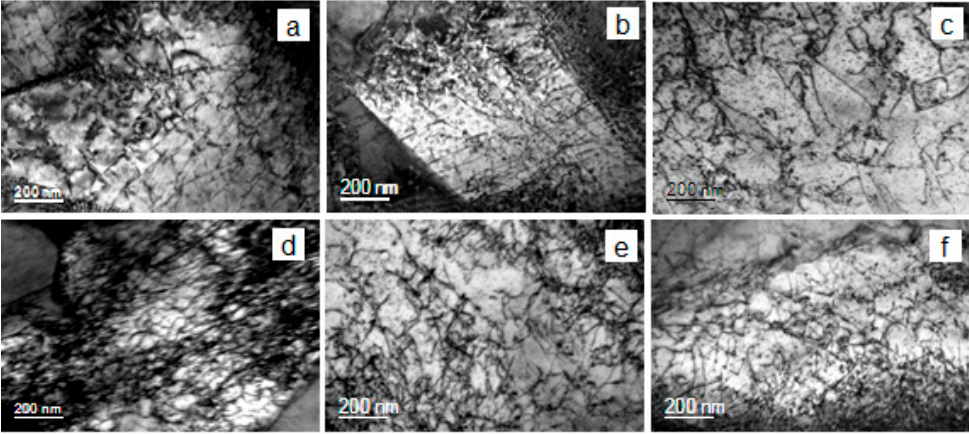
Figure 10. TEM images of typical dislocation structure in ( a – c ) Ti ‐ steel and ( d – f ) MoNbTi ‐ steel, after processing according to schedule ( a , d ) A, ( b , e ) B and ( c , f ) C (see Figure 1).